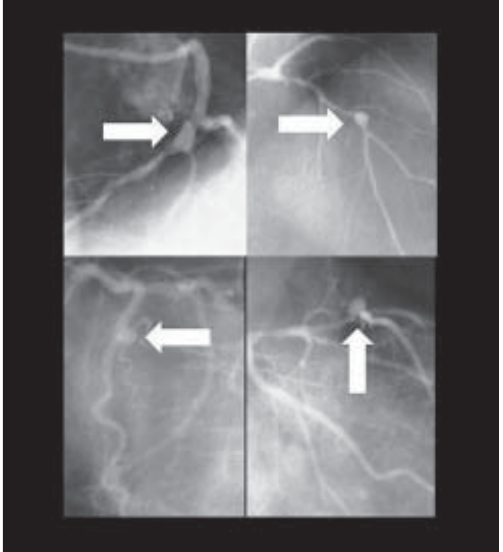
Fig. 4 - Aneurysms of the coronary arteries after stent